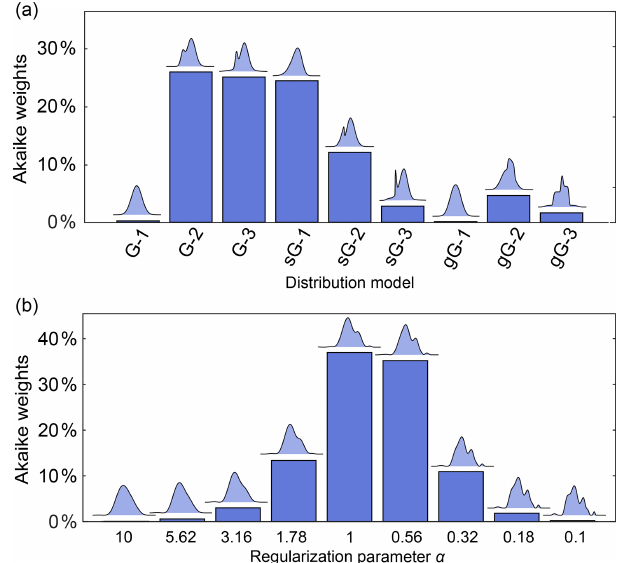
Figure 11. Model comparison using Akaike weights. The Akaike weights (in percentages) are given for (a) a set of parametric dis- tance distribution models with varying number n of ordinary (G-n), skewed (sG-n) and generalized (gG-n) Gaussians and (b) for non- parametric distance distributions determined over a set of values for the regularization parameter α . For each model in panels (a) and (b) , the corresponding distance distribution is shown above the bar. Panels (a) and (b) are based on different simulated DEER signals of different